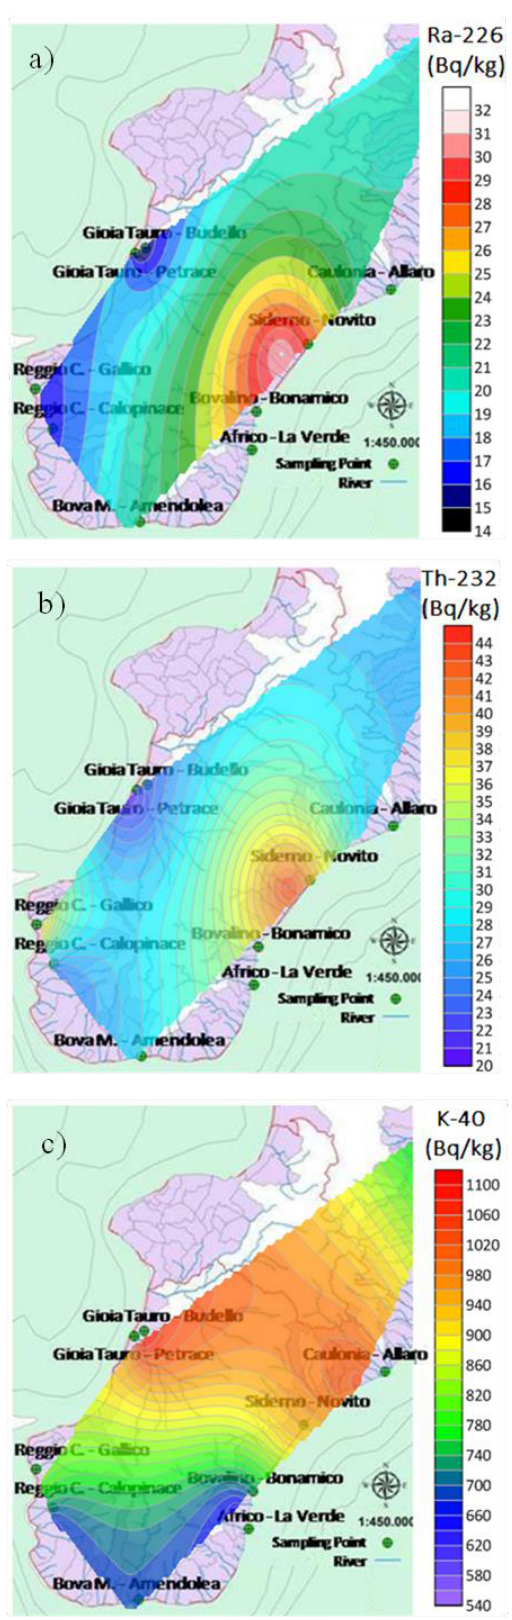
Figure 2. Contour maps showing the spatial distributions of ( a ) 226 Ra, ( b ) 232 Th and ( c ) 40 K in the investigated